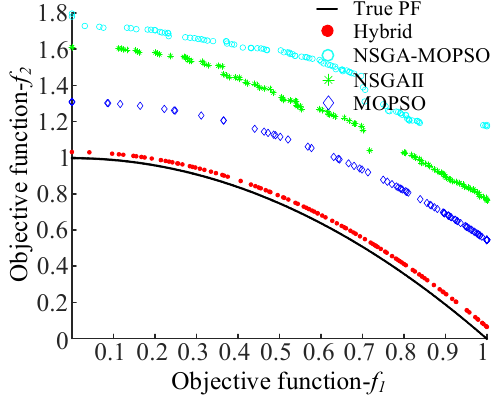
Figure 4. Comparison results for ZDT2.